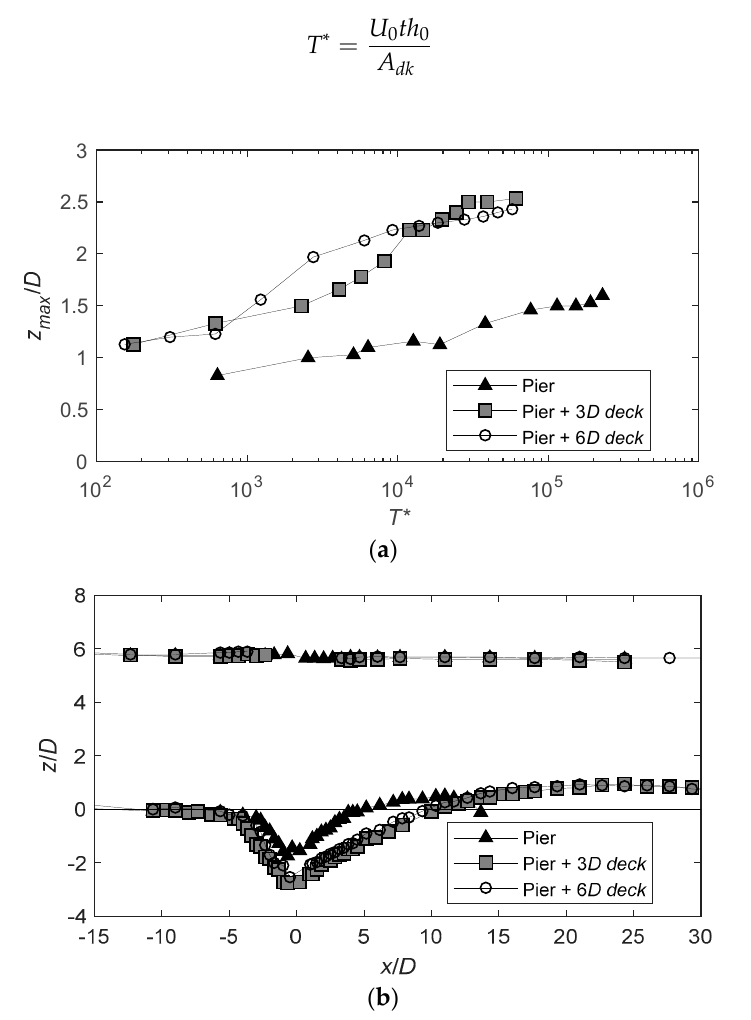
Figure 2. ( a ) Temporal scour evolution measured in proximity of the pier for the three different tested configurations, and ( b ) longitudinal scour and liquid profiles at maximum scour section and at the end of the tests (6 h).